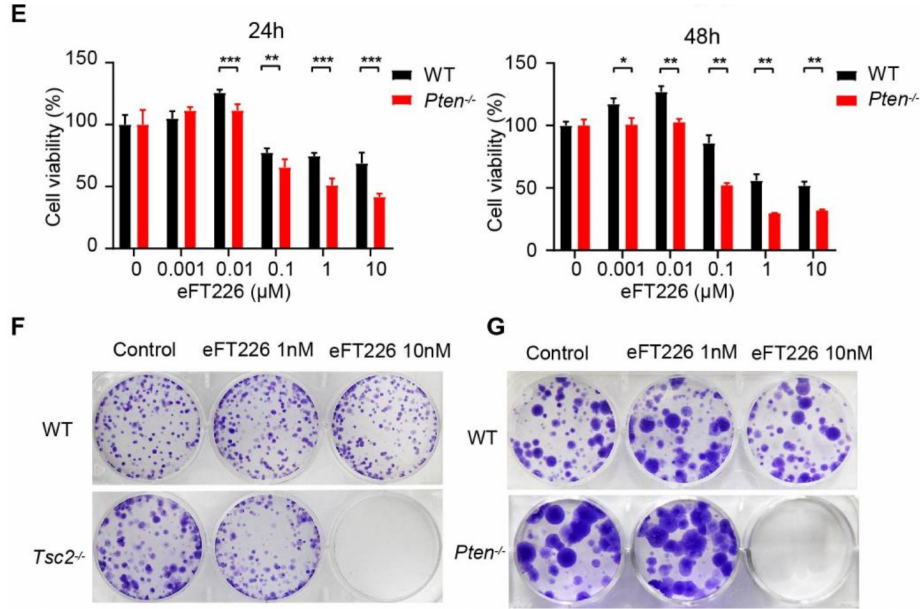
Figure 1. Tsc2 - and Pten -deficient cells are more sensitive to eFT226 treatment. ( A ) Immunoblot analysis of mTOR and its downstream translation initiation factors in Tsc2 - and Pten -deficient MEFs. ( B ) Tsc2 -deficient MEFs were treated with rapamycin for 48 h. ( C ) Chemical structure of eFT226. Tsc2 - ( D ) and Pten -deficient ( E ) MEFs were treated with eFT226 for 24 h and 48 h at the indicated concentration in quintuplicate. Cell viability was assessed by CCK-8 assay. Colony formation of Tsc2 - ( F ) and Pten -deficient ( G ) MEFs treated with eFT226 or its solvent DMSO in triplicate. ( B , D , E ) are the results of triplicate experiments. ( F , G ) are one set images from duplicate experiments. Error bars represent mean ± SD. * p < 0.05; ** p < 0.01; *** p < 0.001.